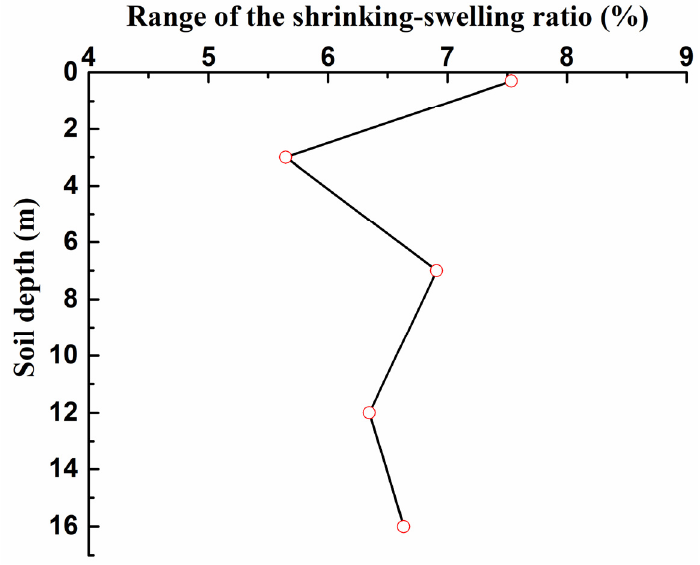
Figure 6. Range of shrink–swell ratio of the studied weathering profile.